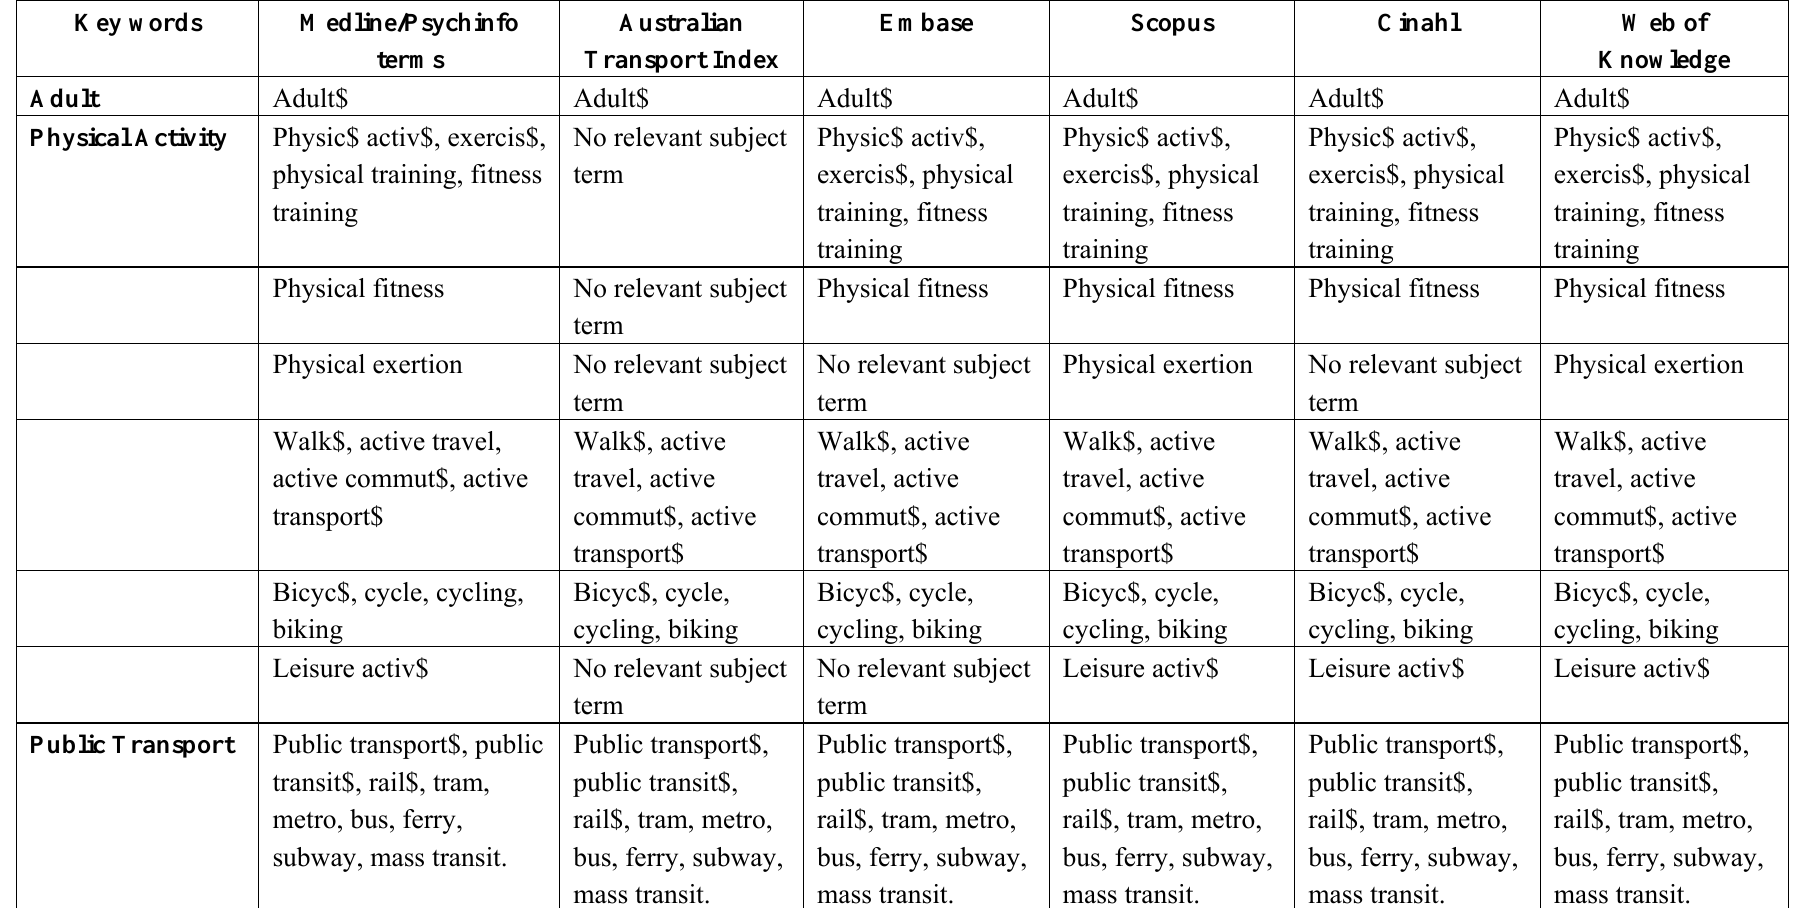
Table 1. Electronic search